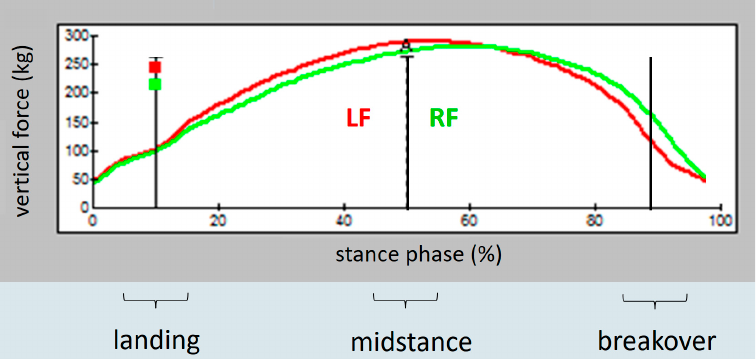
Figure 6. Averaged pressure-time-curve of one horse in the current study with right forelimb lameness: vertical force in kg on the left (red) and anaesthetised right (green) forelimb during landing (10% of the stance phase), midstance (50% of the stance phase), and breakover (90% of the stance phase) after anaesthesia.